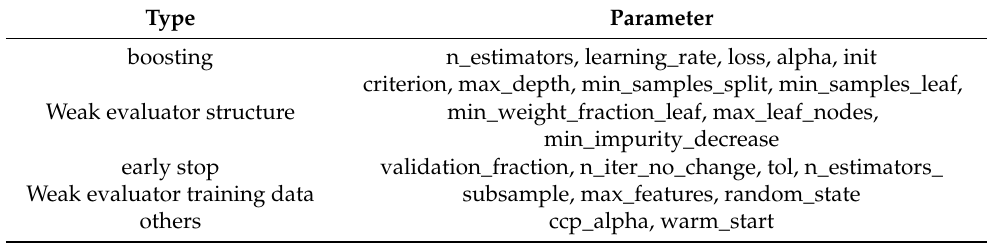
Table 1. Categories of GBDT hyperparameters.